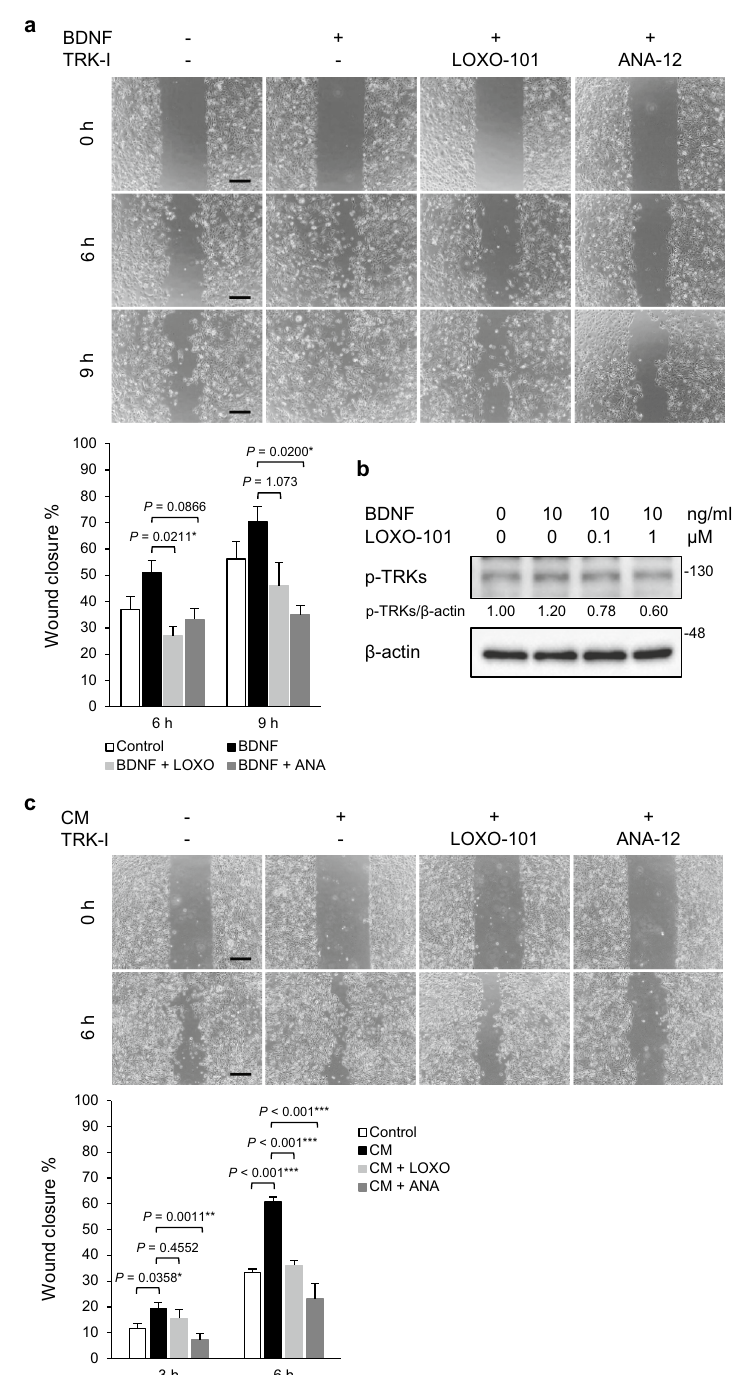
Figure 4. Suppression of BDNF-induced cell migration of PGC cells by TRK inhibitors. (a) Wound healing assay. After serum starvation (0.5% FBS for 24 h), PGC cells were pre-treated with LOXO-101 (a pan-TRK inhibitor, 100 nM) or ANA-12 (a TRKB specific inhibitor, 10 μM) for 1 h, and a wound healing assay was performed. The migrating cells were imaged and cell migration was estimated as wound closure percentage at the indicated time points (0, 6, and 9 h). Histograms depict the percentages of wound closure as the means ± SEM of triplicate wells from three independent experiments. Scale bars, 100 μm. * P < 0.05 (Tukey’s test). ( b) Phosphorylation of TRKB in PGC cells was determined by WB analysis. After serum starvation (0.5% FBS for 24 h), PGC cells were pre-treated with LOXO-101 (100 nM) for 1 h and subsequently cultured in the presence or absence of BDNF (10 ng/mL) for 30 min. The relative amounts of p-TRKs are indicated as the ratio of each protein band relative to the loading control, β-actin. ( c) Wound healing assay with CM from PGC/ CAF co-cultures. Data shown are means ± SEM of quintuple wells and are representative of three independent experiments. TRK-I, TRK inhibitor. *** P < 0.001, ** P < 0.01, and * P < 0.05 (Tukey’s